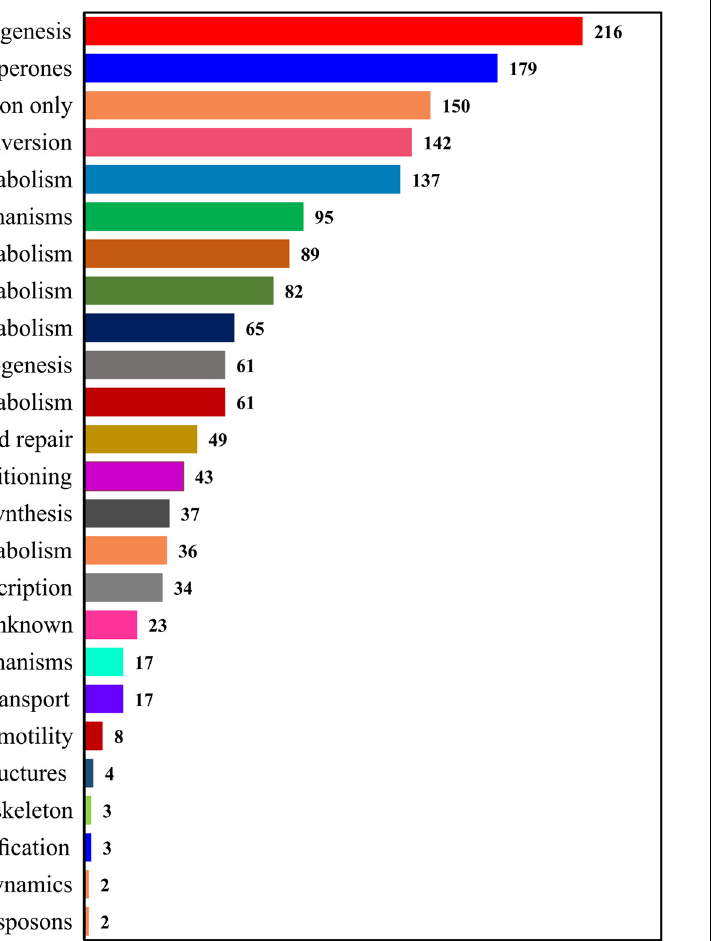
FIGURE 3 | Representation of the protein sets from complete genomes in the